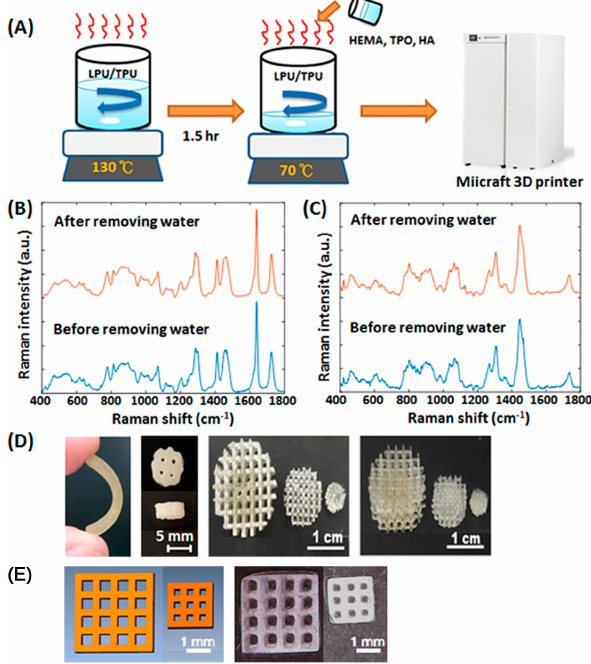
Figure 1. ( A ) The schematics of the manufacturing process of the water-based polyurethane based photosensitive materials; The Raman spectra of the ( B ) water-based light-cured polyurethanes and ( C ) water-based thermoplastic polyurethanes with or without water removal processes; ( D ) The images of the printed scaffolds; ( E ) The images of the designed (left) and printed (right) porous lattice